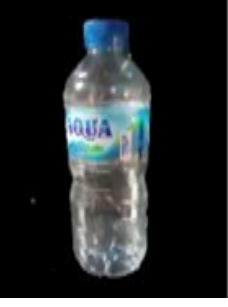
Figure 7. Result GrabCut Image